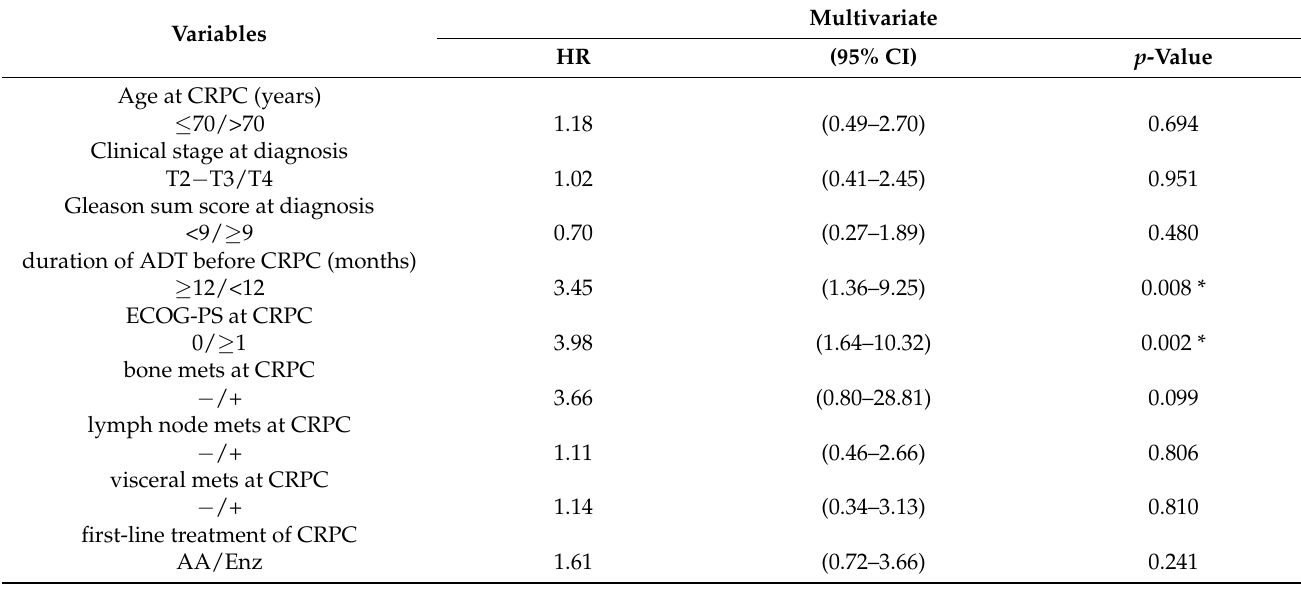
Table 4. Multivariate analyses for OS in 97 mCRPC patients without >30% PSA decline (PSA30D) at four weeks of the first-line treatment using